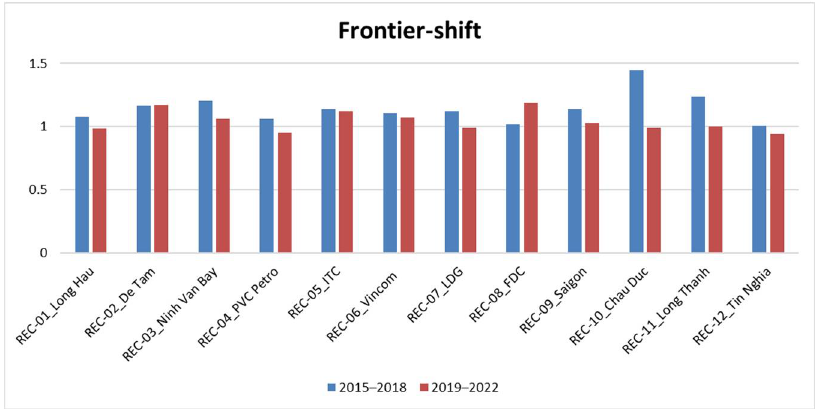
Figure 8. The comparison of technological efficiency change.